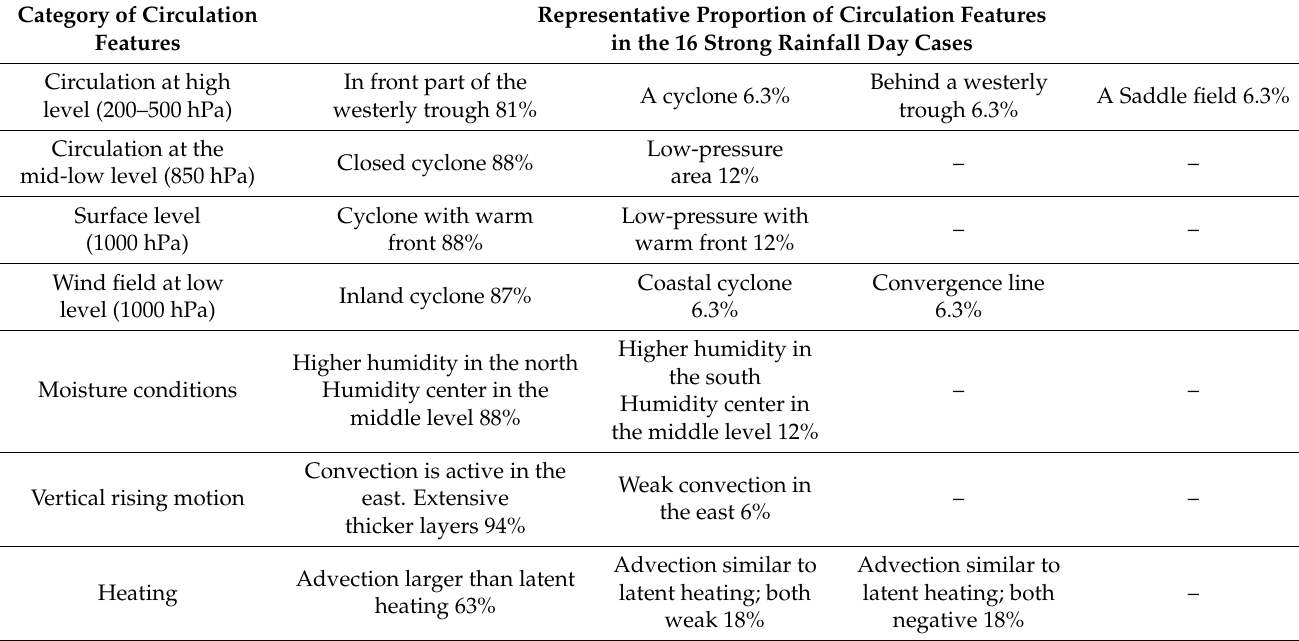
Table 1. Representative proportion of the basic characteristics of strong rainfall system circulation